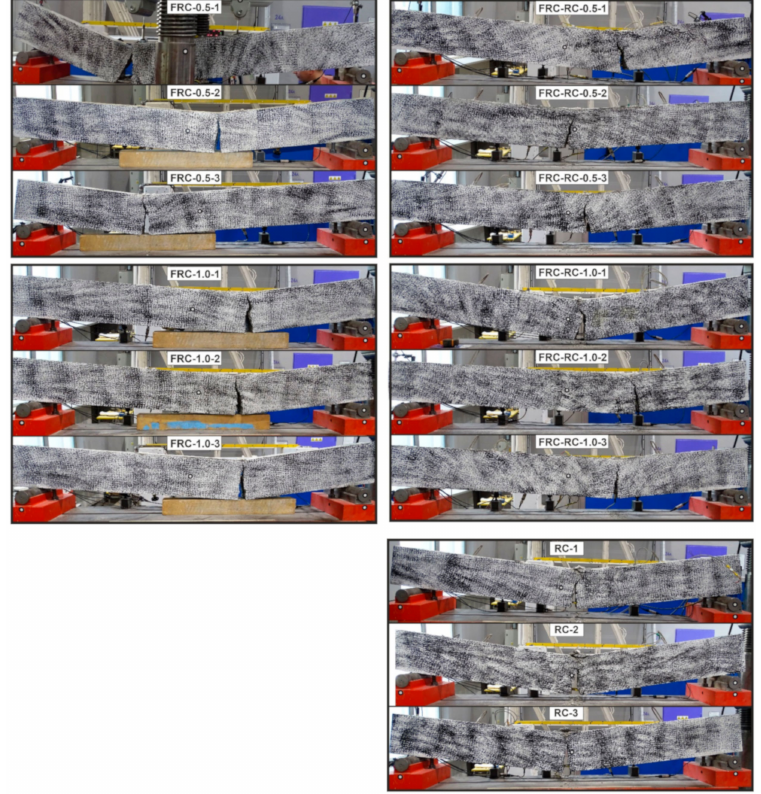
Figure 21. The view of the beams after the